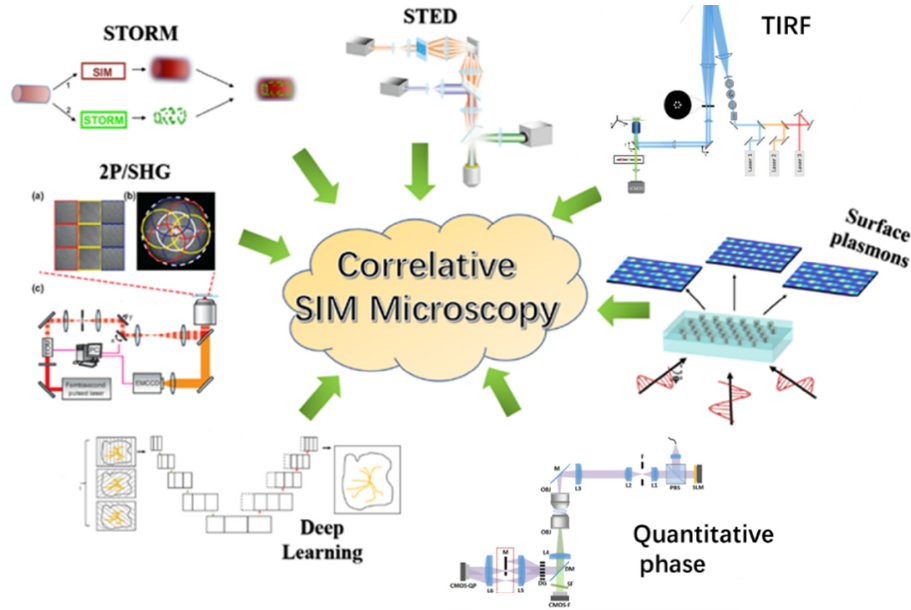
Figure 1. Schematic diagram of the correlative structured illumination microscopy with other microscopy techniques.